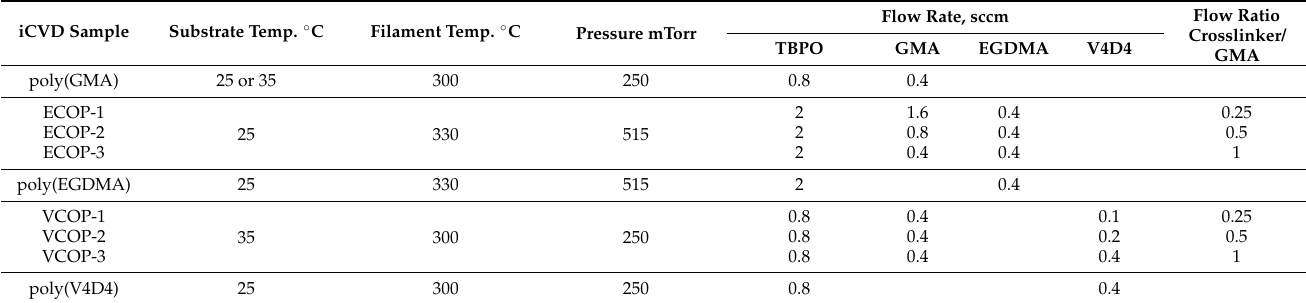
Table 1. Summary of iCVD process conditions for